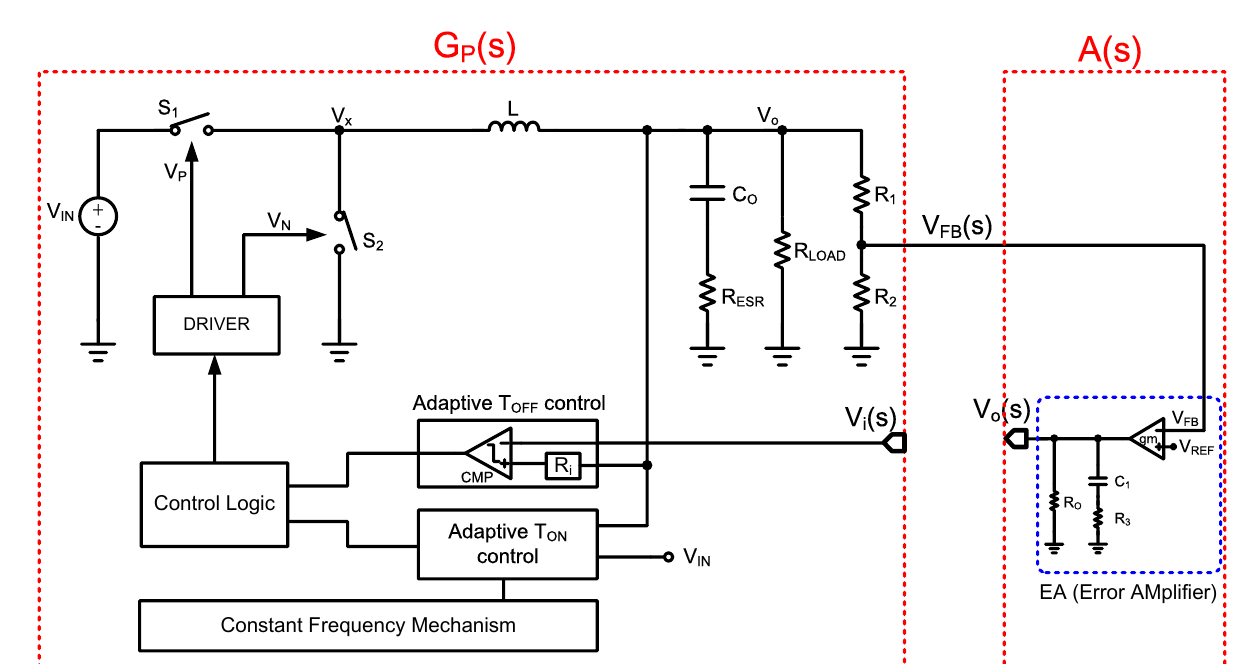
Figure 7. Open loop structure of the proposed converter.